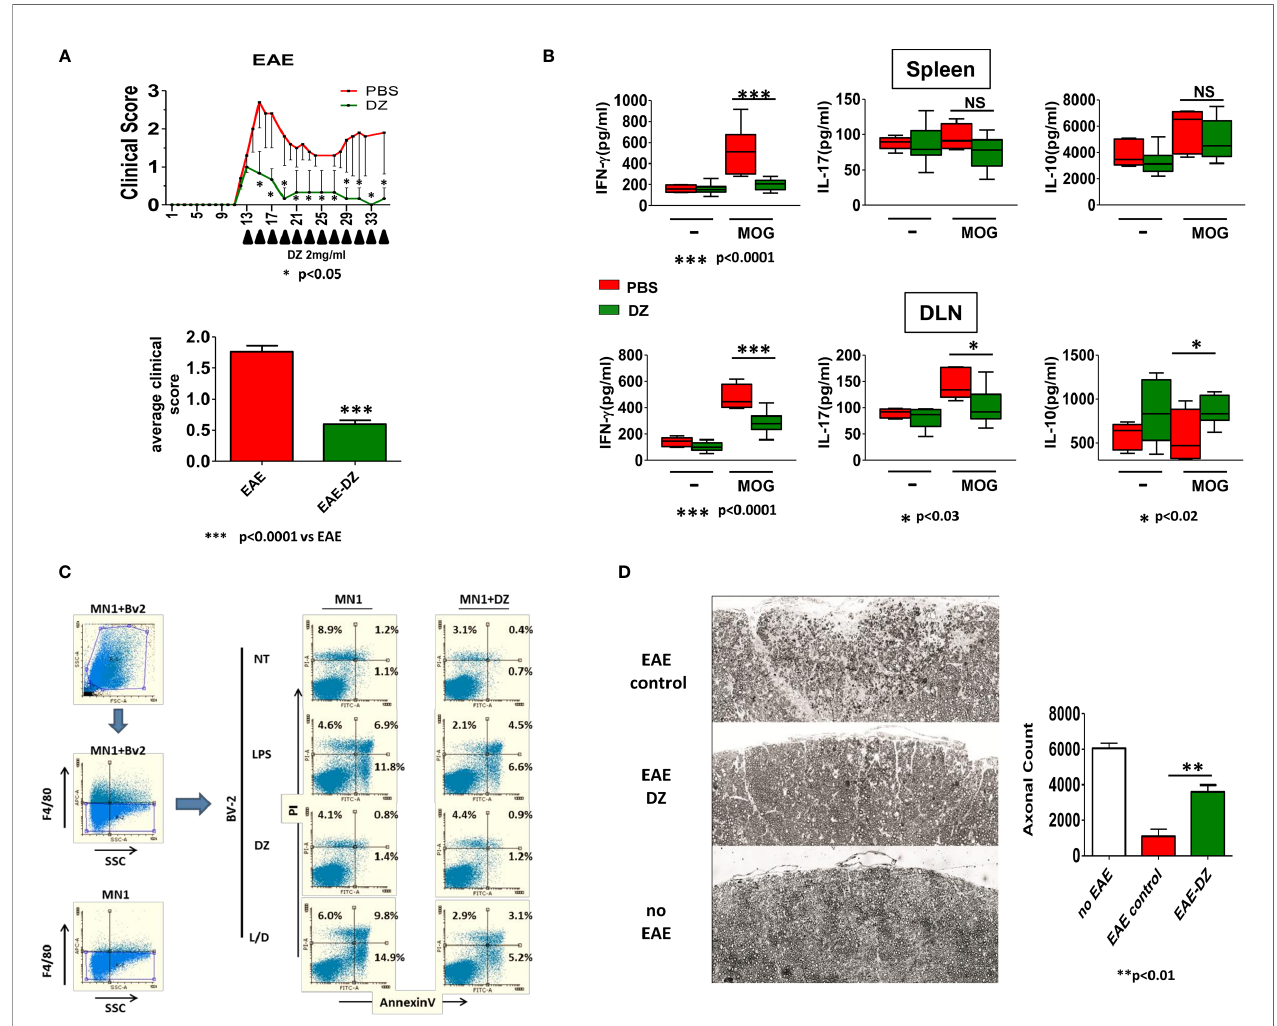
FIGURE 6 | Therapeutic DZ administration reduces the severity of EAE. DZ was i.p. administered to mice challenged for the disease in alternate days when they reached a score of 1. (A) Clinical score was evaluated daily. Clinical scores of experimental groups were statistically analyzed by Mann – Whitney test, p < 0.05. (B) Cells isolated at 35 dpi from spleen and draining lymph nodes (DLN) from EAE animals, treated or untreated with DZ, were re-stimulated in vitro in the presence of MOG (10 µg/ml) and IFN- g , IL-17, and IL-10 production was determined by ELISA. (C) BV-2 microglial cells were cultured with medium, LPS (1 µg/ml), DZ (25 µM) or combination LPS plus DZ, for 18 h, then were co-cultured with untreated or DZ-treated MN-1 cells. Apoptosis and death of F4/80 negative cells were analyzed by fl ow cytometry. (D) DZ was i.p. administered to mice challenged for the disease in alternate days from day 7. At day 35 p.i. mice were sacri fi ced, and the axons in the medial dorsal column on the spinal cord at C5 were manually quanti fi ed (n = 6). Signi fi cant differences of cells from DZ- vs. non-treated EAE animals are indicated by ** p < 0.01. Non-signi fi cant values are expressed as